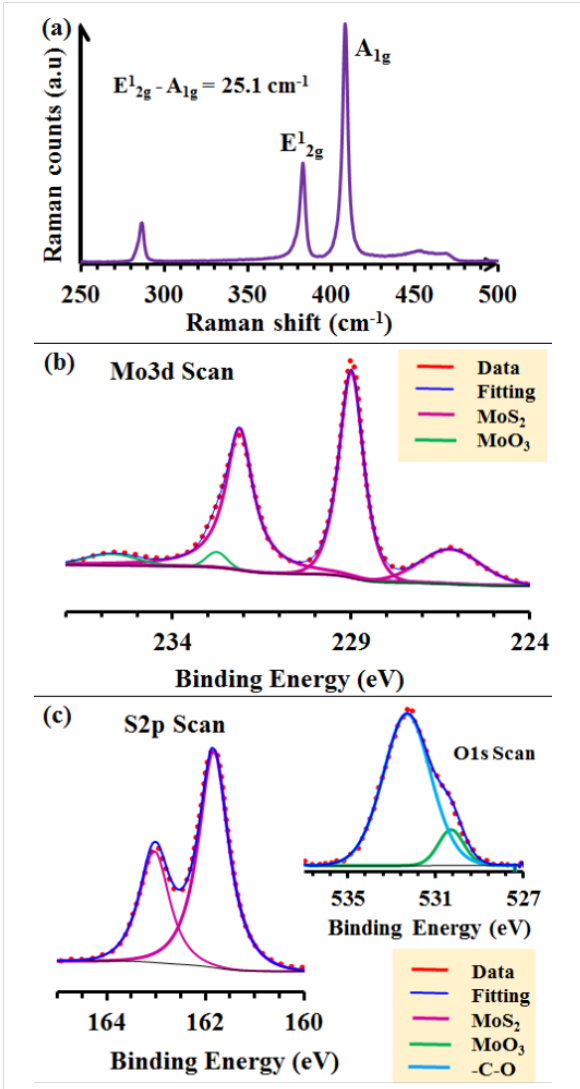
Figure 2: MoS 2 NSs grown by double sulfurization of a 50 nm Mo film at 850 °C on SiO 2 /Si substrates: (a) typical micro-Raman spectrum; (b) Mo 3d core level and (c) S 2p core level with, in the inset, the O 1s core-level spectrum. The doublet peaks marked with identical color correspond to one phase. More detailed information is summarized in Table S1 (Supporting Information File 1).